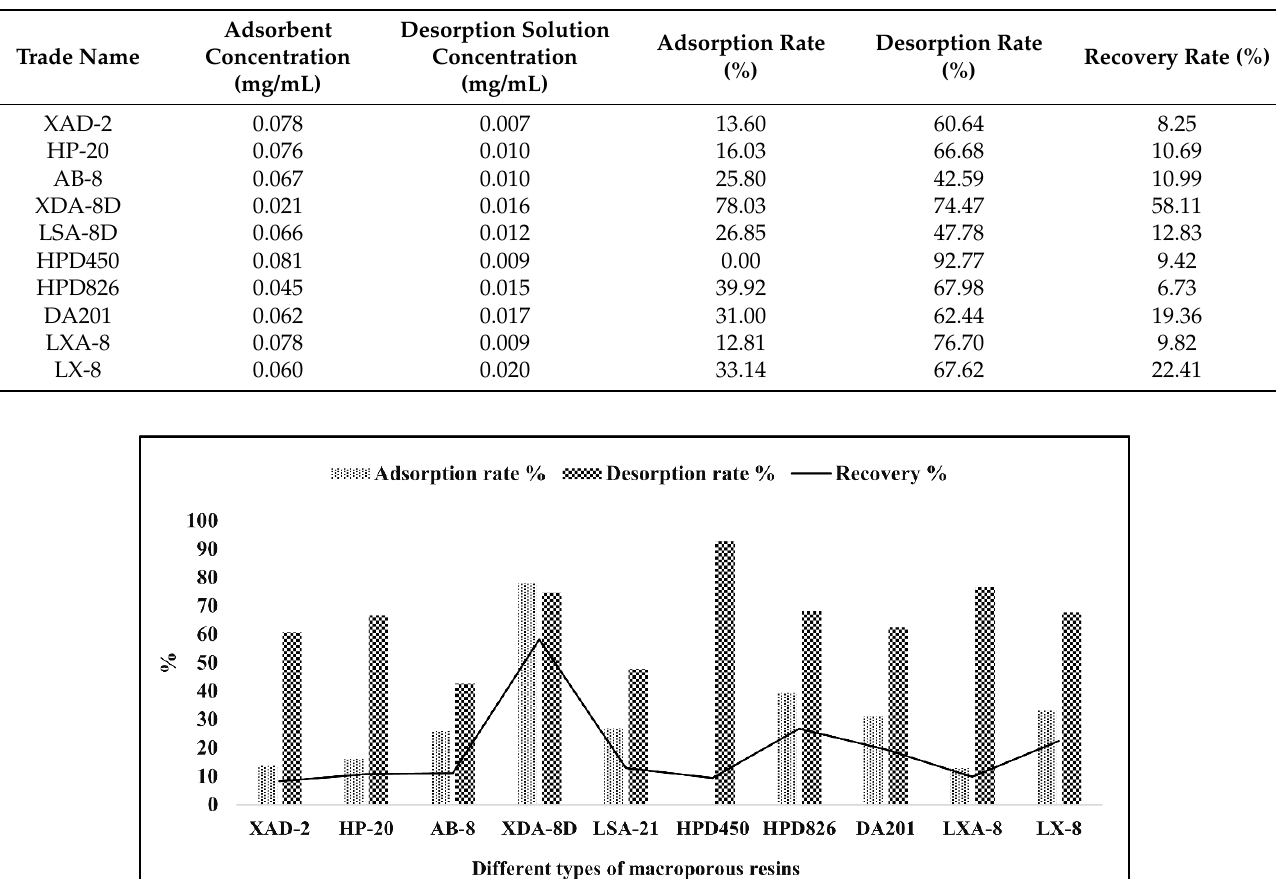
Table 2. Results of the static adsorption and desorption of macroporous resins.